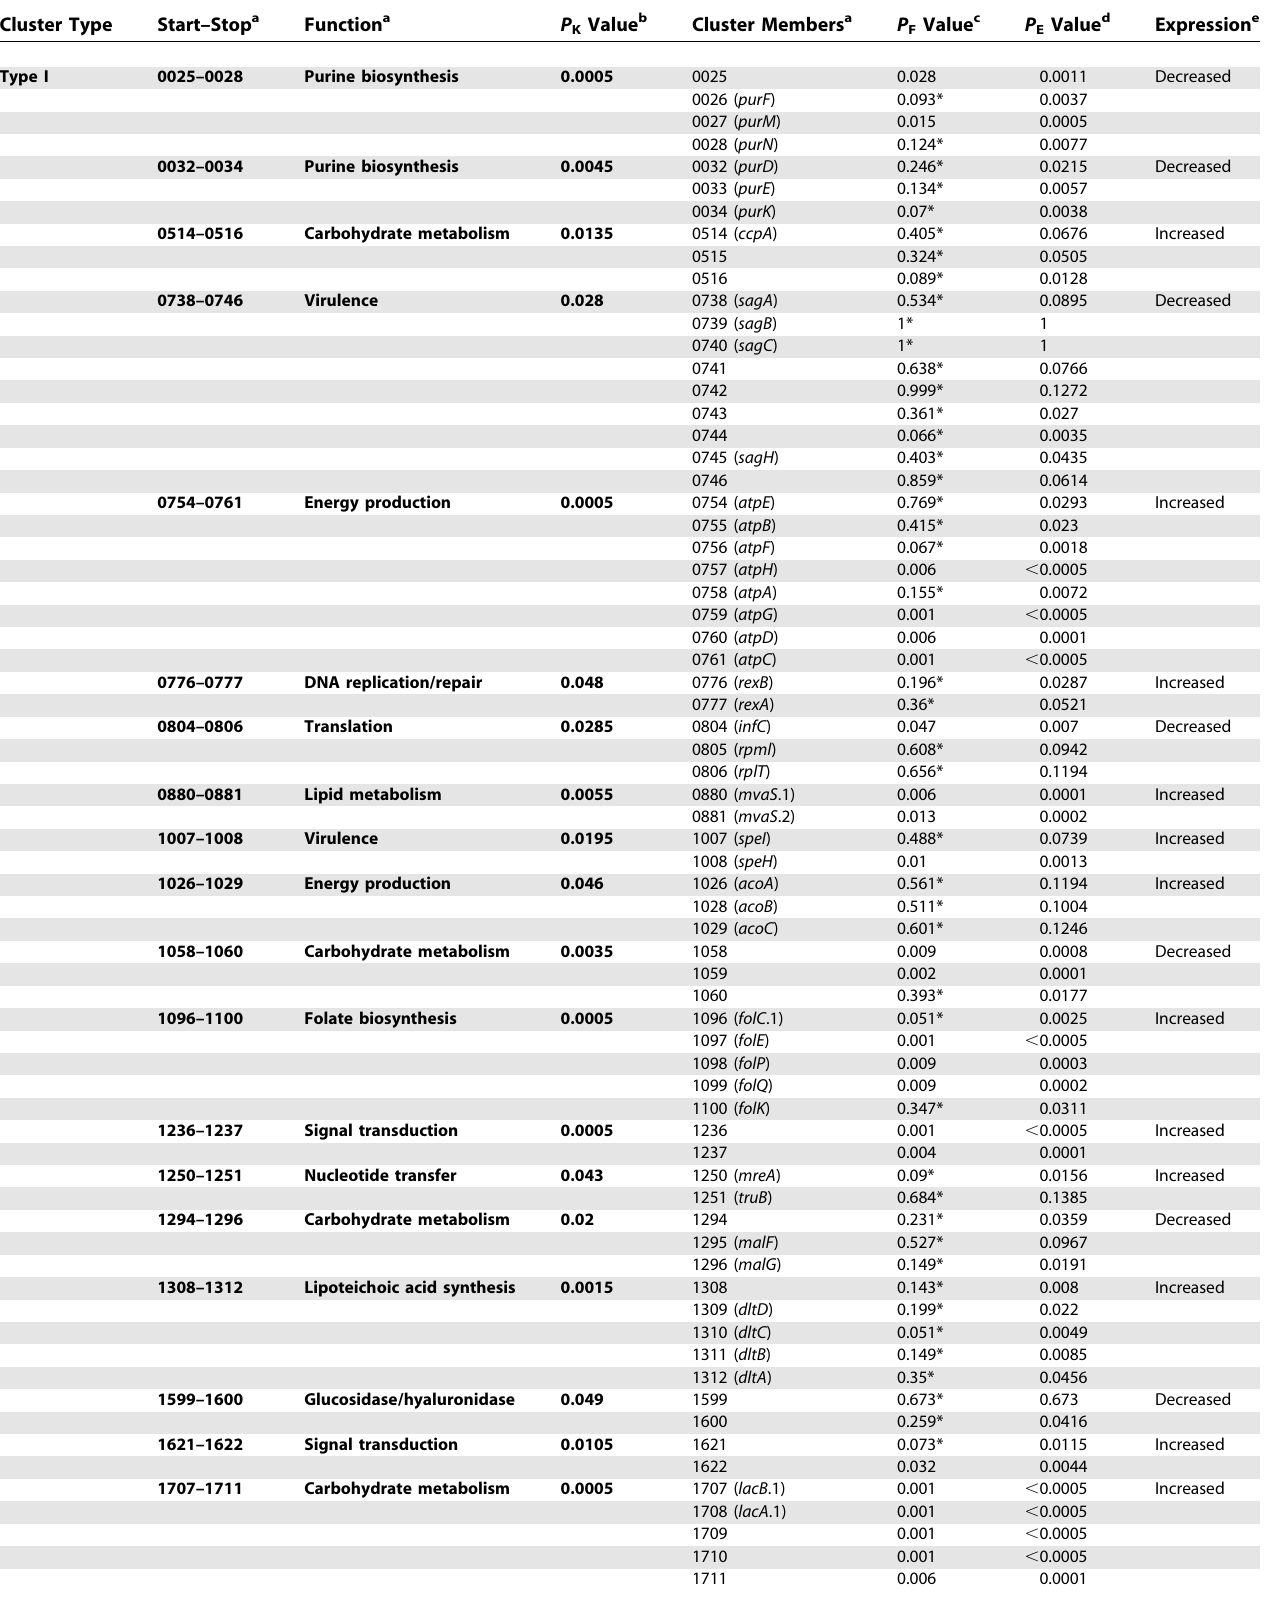
Table 3. Qualifying Neighbor Clusters Identified in the S. pyogenes SF370 Genome by GenomeCrawler Analysis of Adherent Versus Associated Microarray